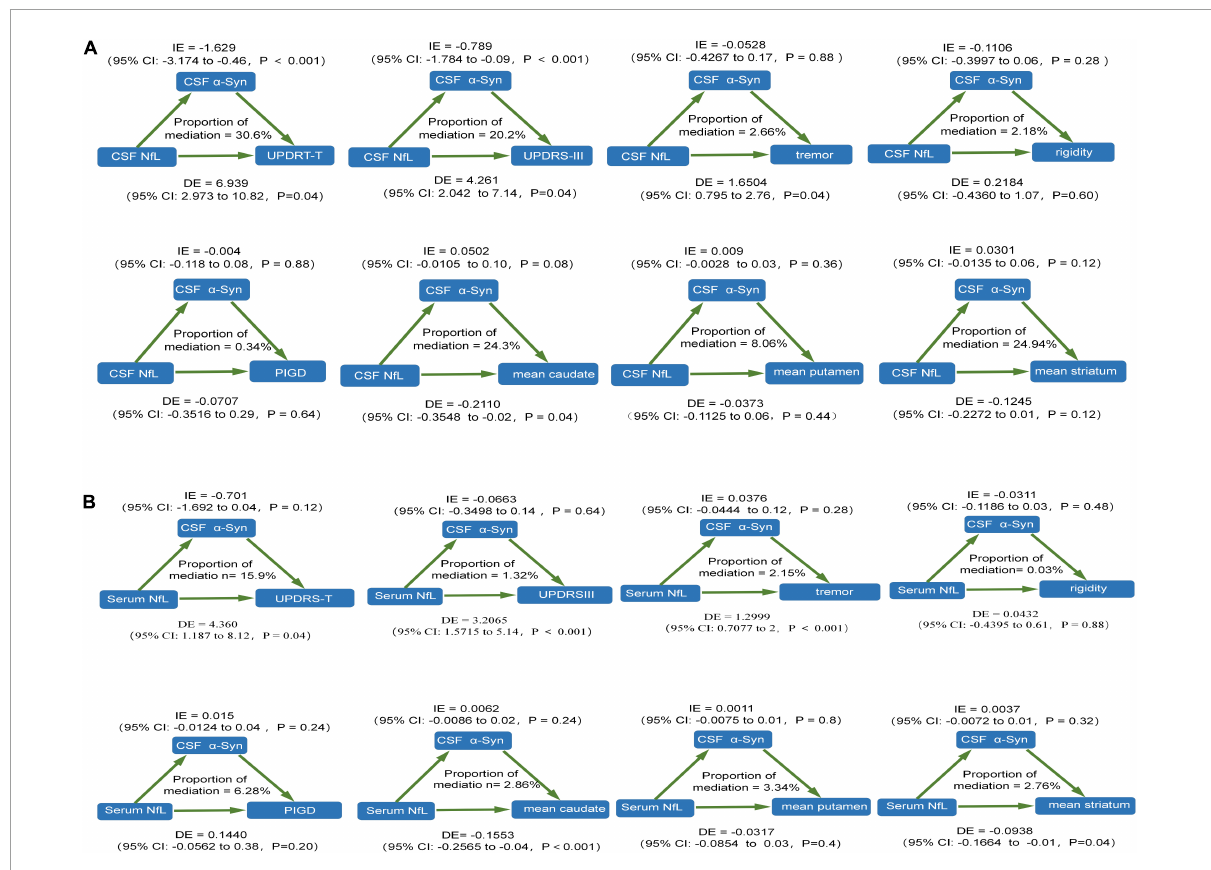
FIGURE3 The relationship between NfL levels and motor features was mediated by CSF α -syn. (A) CSF NfL levels. (B) Serum NfL levels. CSF, cerebrospinal fluid; PD, Parkinson’s disease patients; NfL, neurofilament light; UPDRS, Unified Parkinson’s Disease Rating Scale; PIGD, postural instability and gait